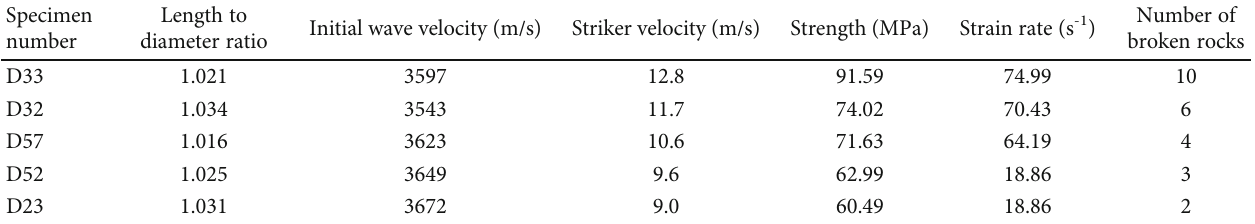
Table 2: Dynamic mechanical properties of granites.